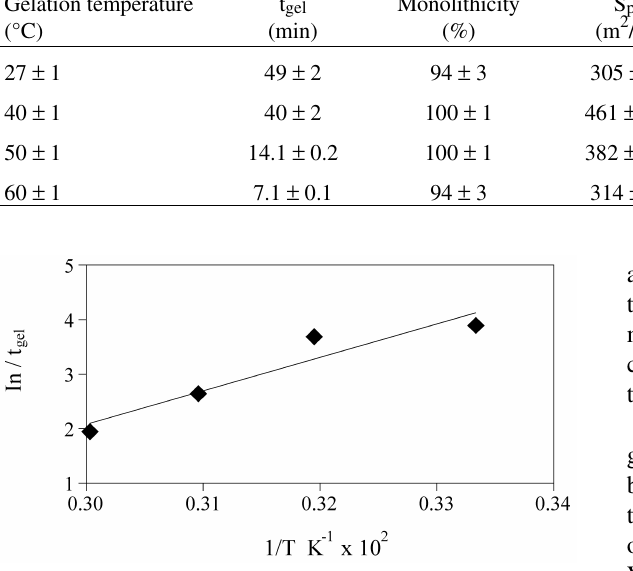
Table 4. Values of gelation time (t gel ), monolithicity, specific surface area (S P ), specific pore volume (V P ), average pore radius (r P ) and bulk density ( ρ V ) of silica gels obtained with the various gelation temperatures. Gelation